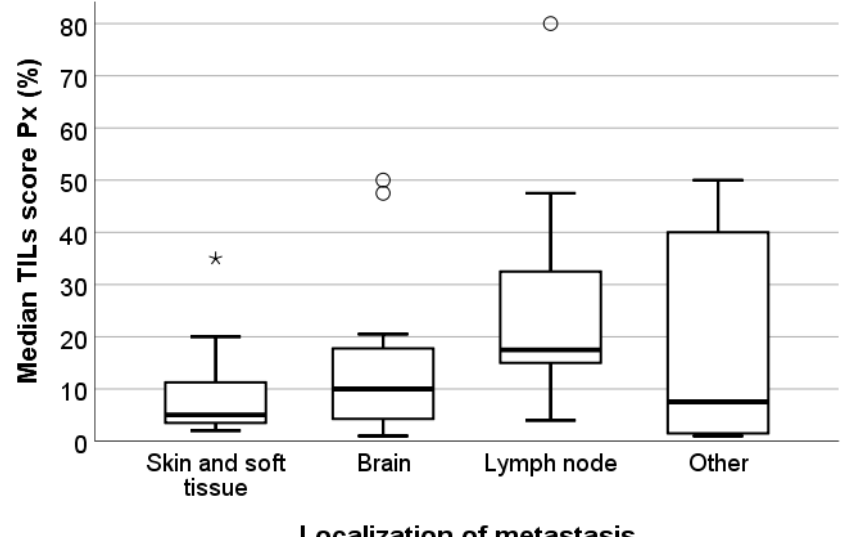
represent extremes, * outliers, ° extremes.